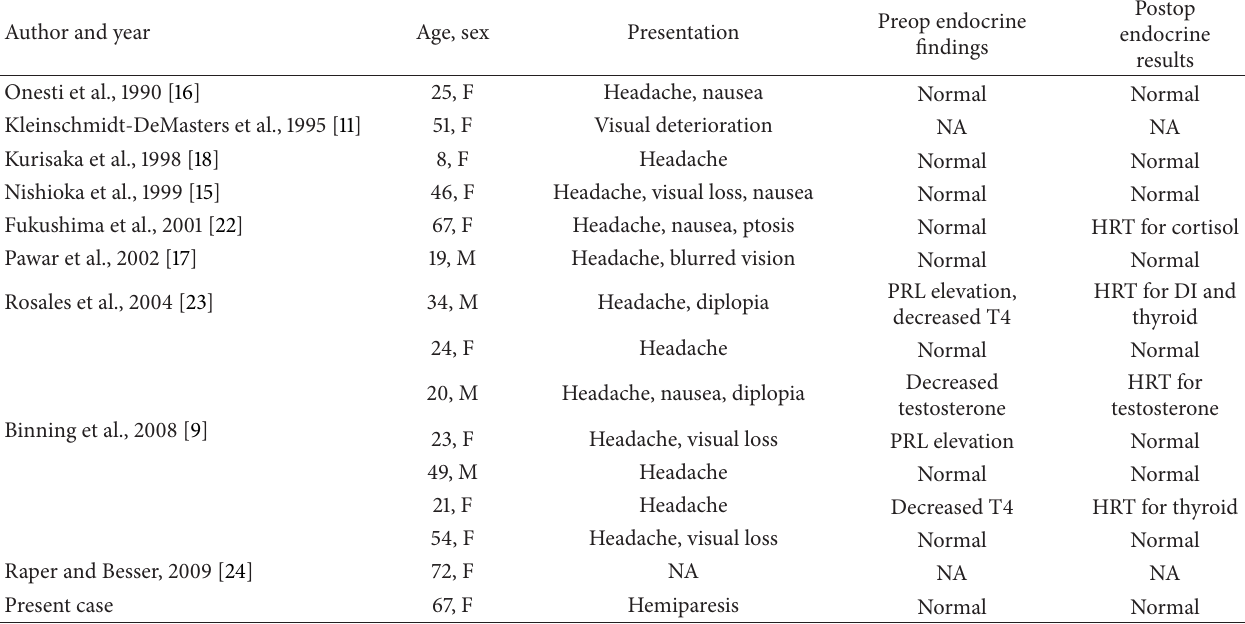
Table 1: Summary of the clinical presentations and endocrinological findings in reported cases of RCC